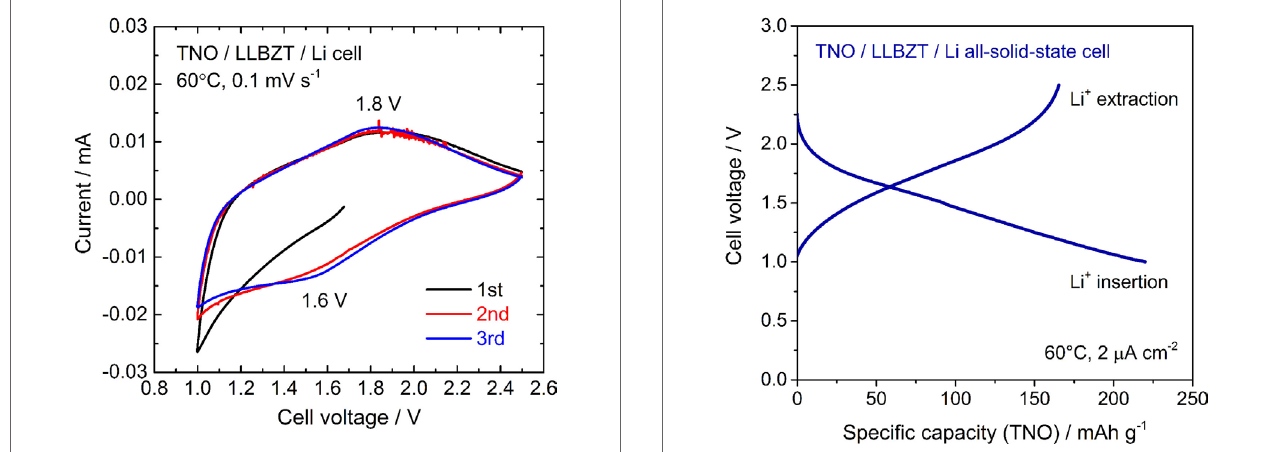
FigUre 13 | charge and discharge curves measured at 60°c and current density of 2 μ a cm − 2 for TnO film electrode/llBZT/li all-solid-state cell